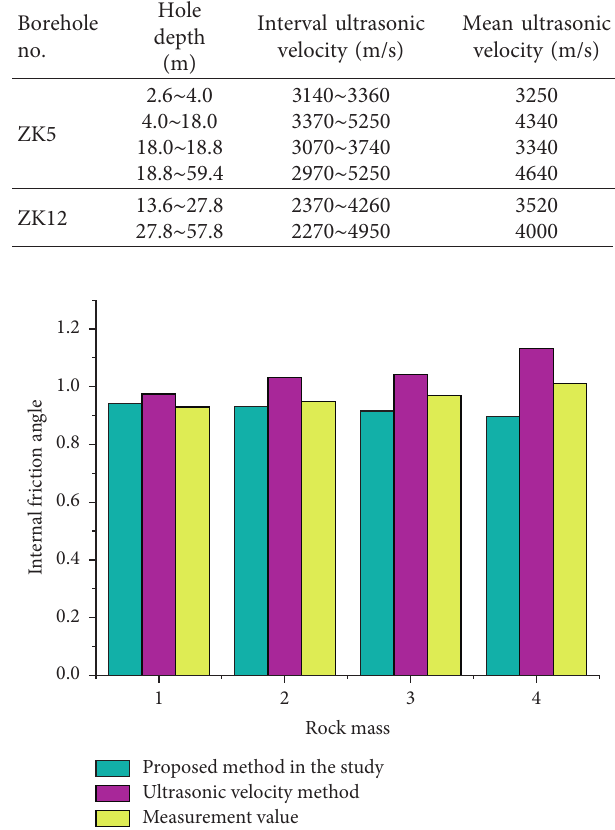
Figure 11: Comparison of the mechanical parameters of the rock mass from two methods and test values in the Mamaya I hydro- power